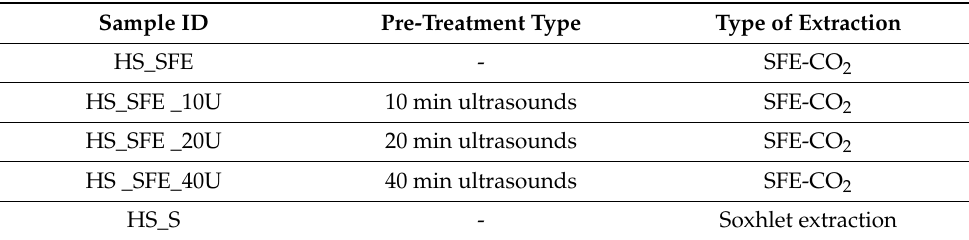
Table 1. Hempseed samples processed by Soxhlet and SFE-CO 2 at different